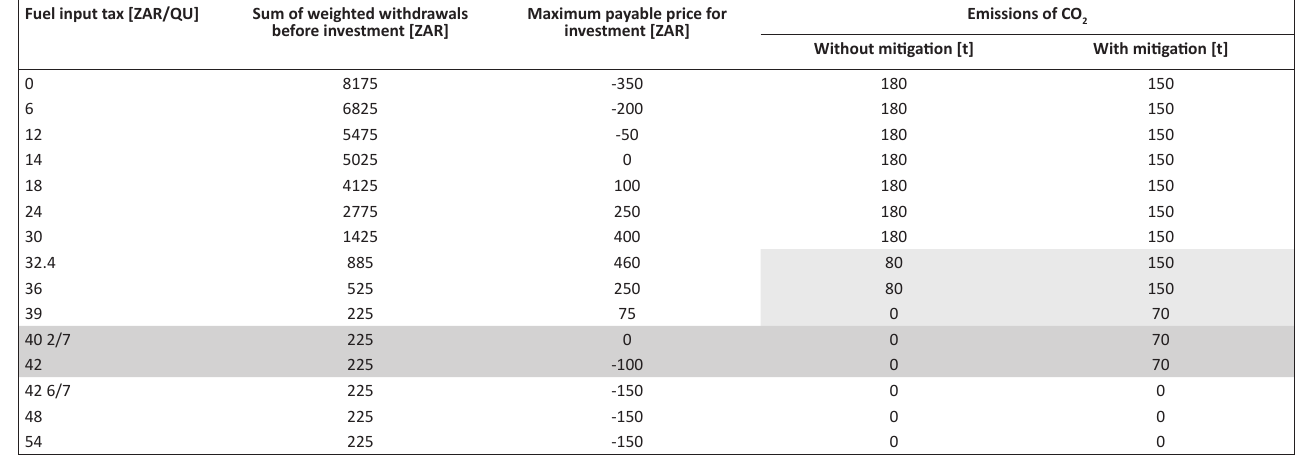
FIGURE 1: Effects of rising fuel input taxes on the optimal solutions of the basic programme and valuation